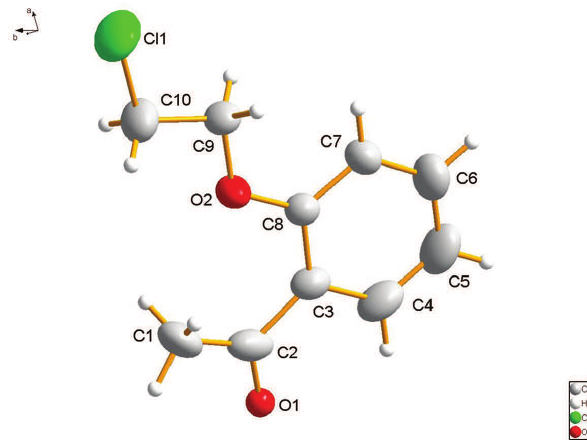
Table 1: Data collection and handling.